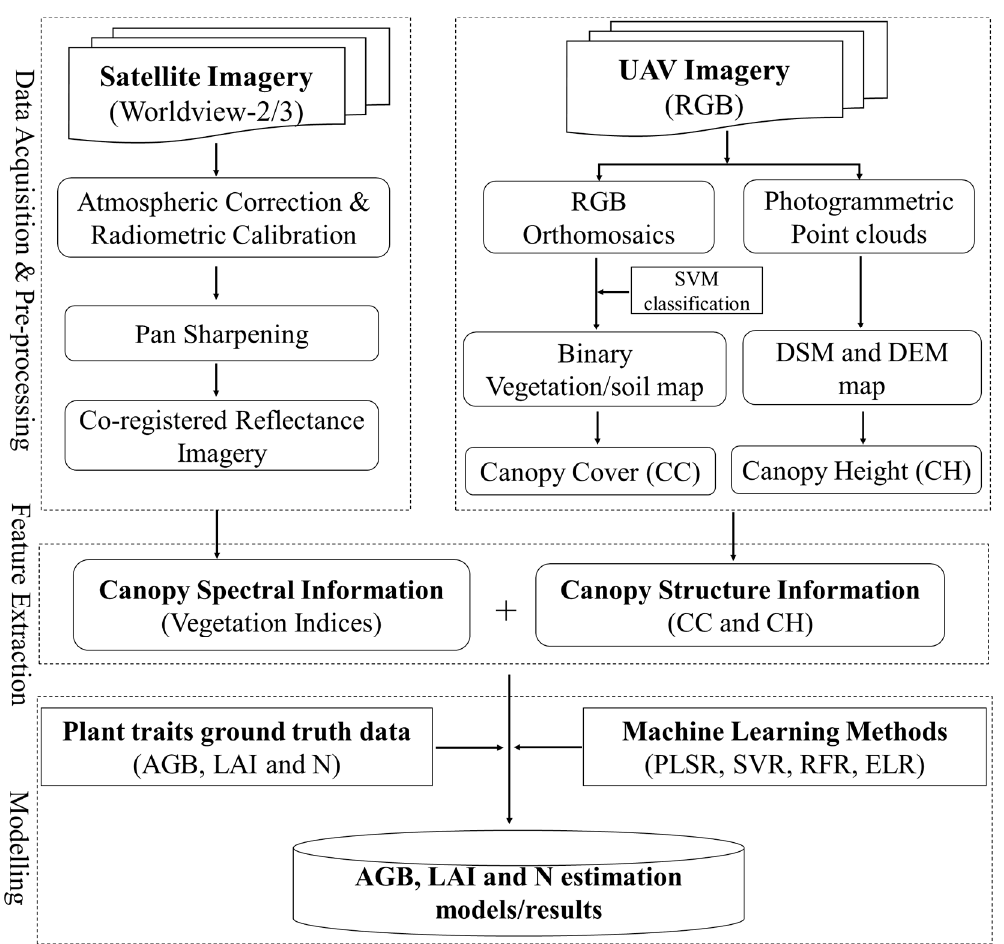
Figure 2. A workflow diagram of remote sensing imagery preprocessing, canopy spectral and structure feature extraction, and model training and testing.